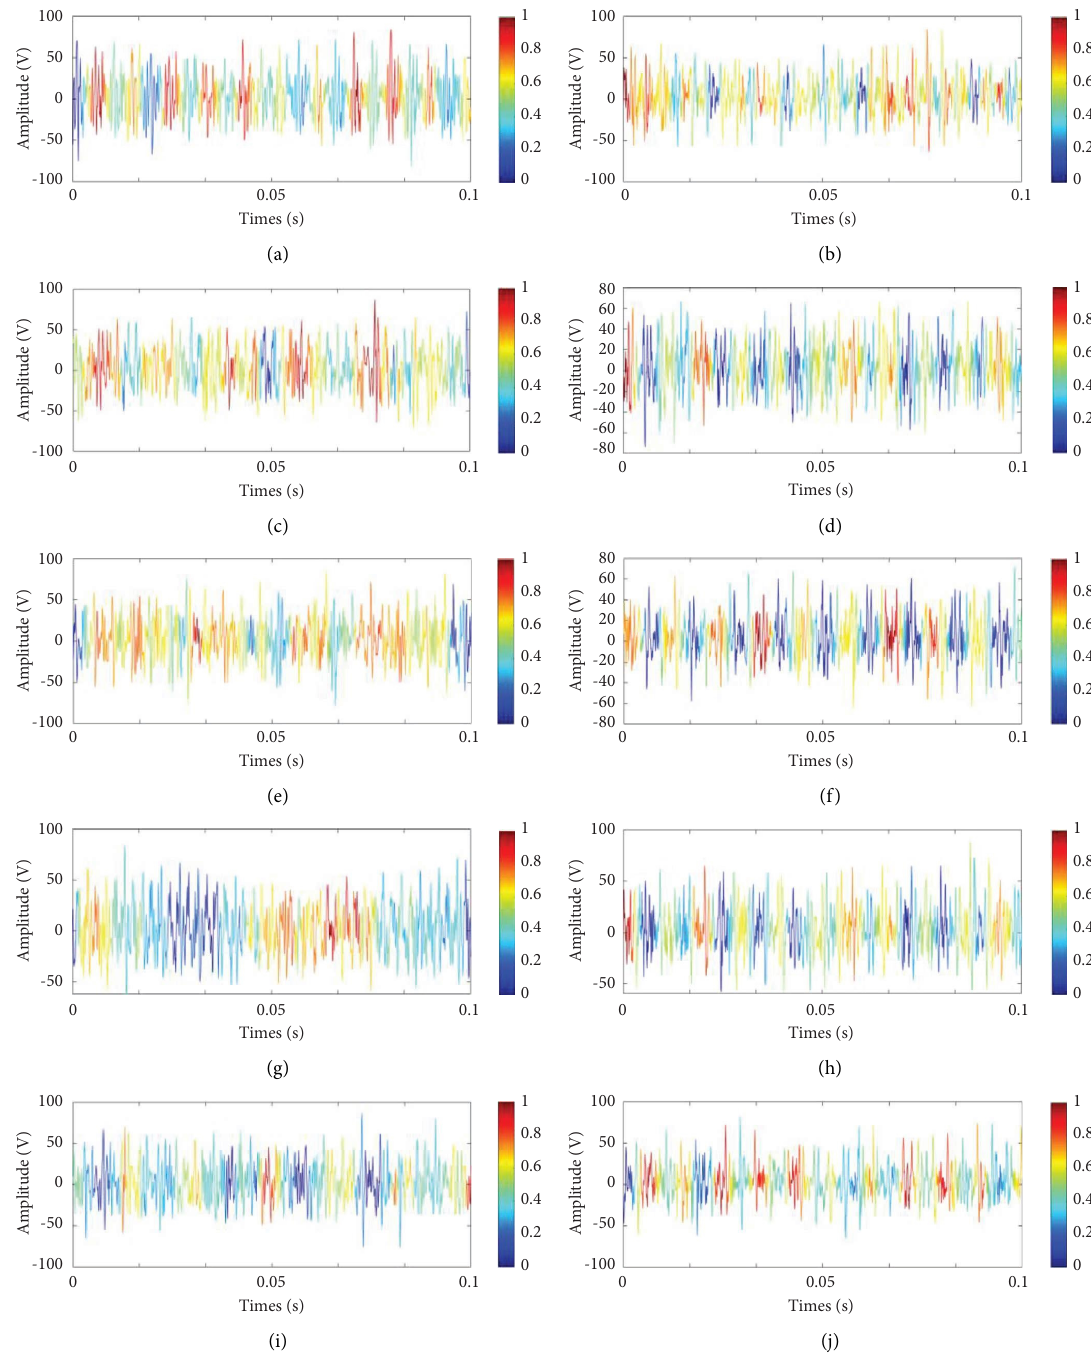
Figure 17: Weight visualization of the last convolution layer under diferent working conditions. (a) Condition1-nomal, (b) condition2- nomal, (c) condition1-Z15, (d) condition2-Z15, (e) condition1-Z18, (f) condition2-Z18, (g) condition1-Z30, (h) condition2-Z30, (i) condition1-Z31, and